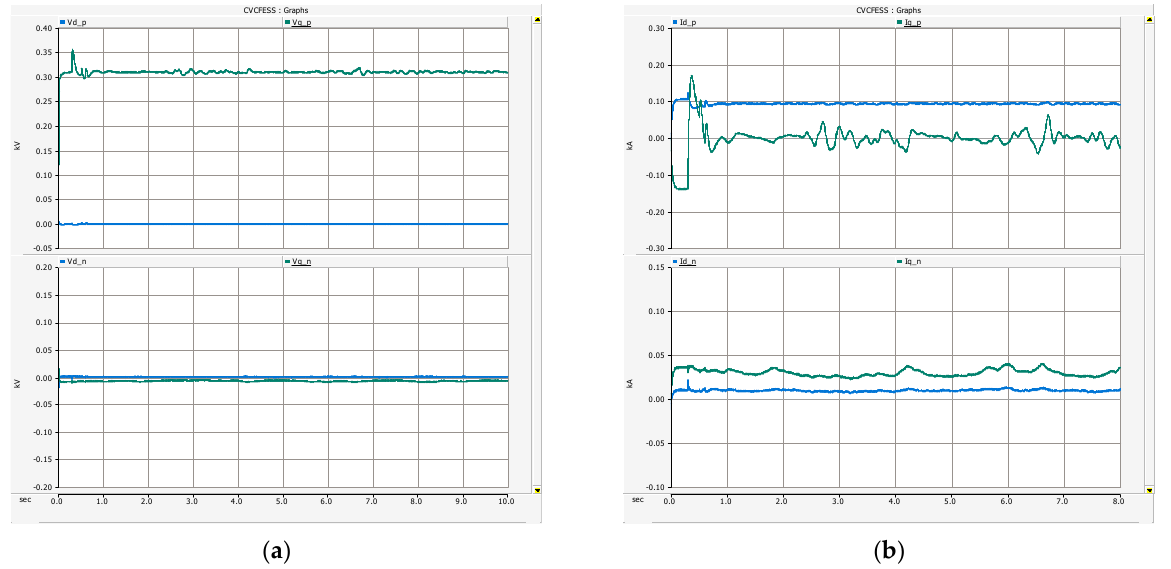
Figure 14. Simulation results of Scenario 1 ( a ) mBESS (top: dq-axis PSV; bottom: dq-axis NSV) and ( b ) mBESS (top: dq-axis PSC; bottom: dq-axis NSC).